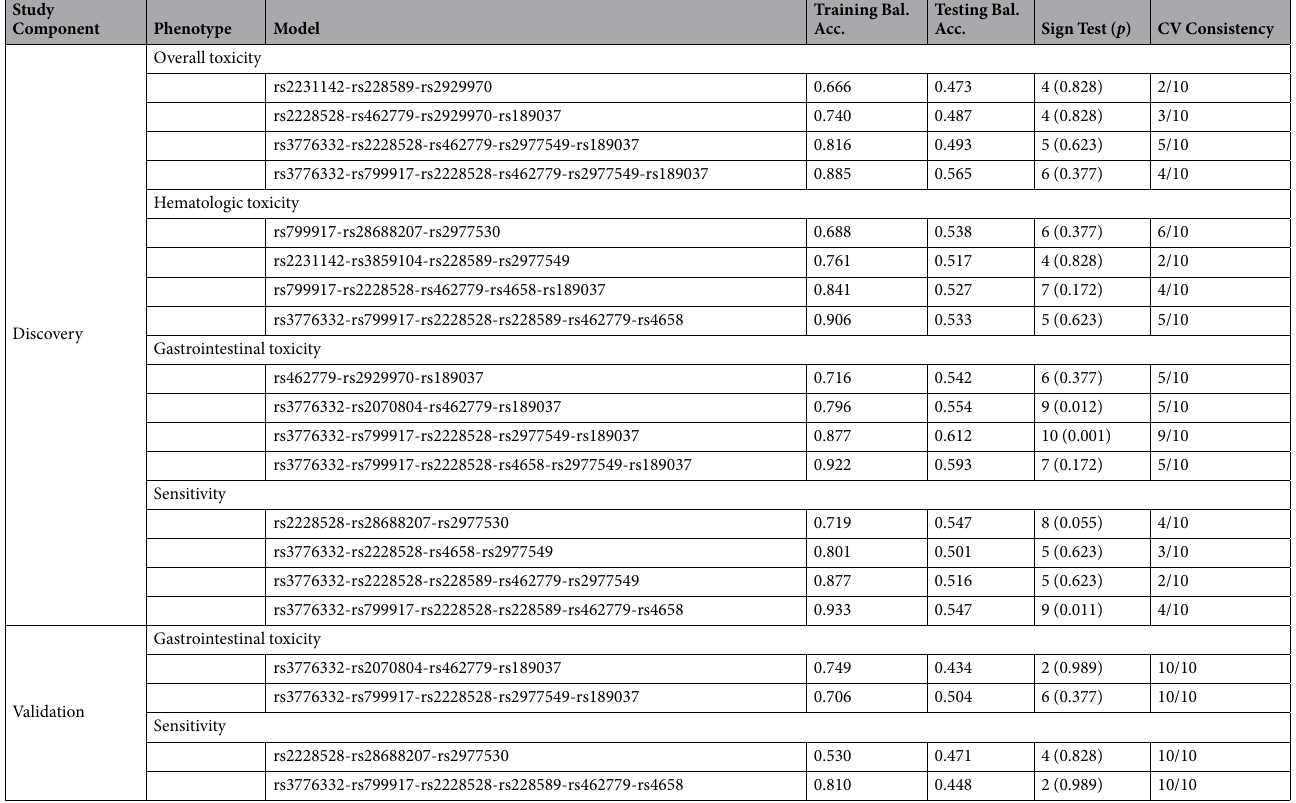
Table 2. Multi-dimensional gene-gene interaction in discovery stage and validation stage.